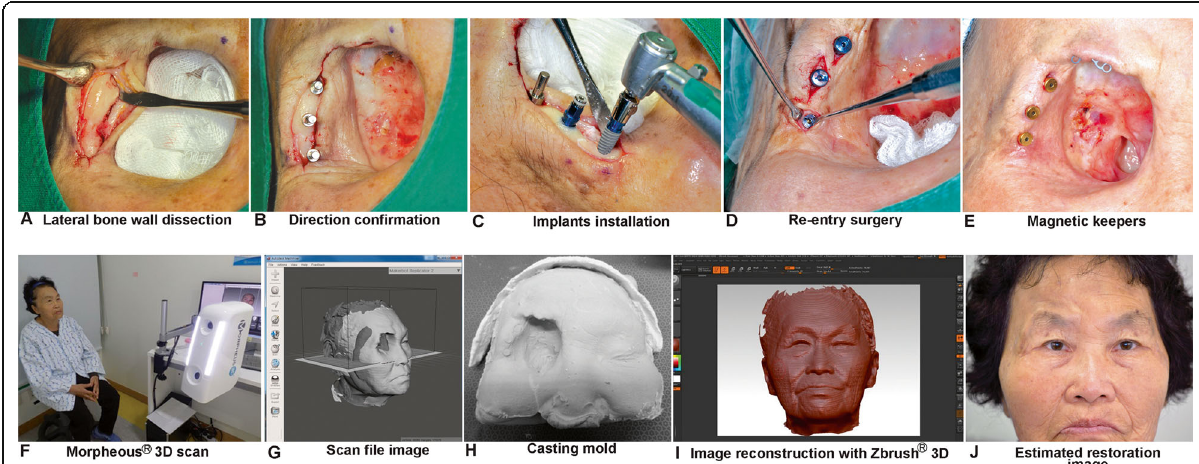
Fig. 2 Dental implant installation and 3D scanning with imaging reconstruction. A full-thickness cutaneous flap that exposed the lateral orbital bony wall ( a ); verification of the direction of three implants after drilling using a 2-mm-diameter drill bit ( b ); three Luna® implants (Shinhung Co., Seoul, Korea) 4.0 mm in diameter × 7.0 mm in length were inserted ( c ); the re-entry procedure showing the cover screws being changed into healing abutments 5 months later ( d ); replacement of the healing abutments with the magnetic keeper (MAGFIT IP-B®, Aichi Co., Japan) 4 weeks later (E); 3D facial scanning ( f ) and imaging reconstruction ( g ) with a Morpheus 3D Scanner® (Morpheus Co., Ltd., Seoul, Korea); 3D printing with the data obtained from facial scanning ( h ); 3D molding using ZBrush® image reconstruction software (Pixologic Inc., California, USA) to reconstruct the area with the defect ( i ); and application to the patient ’ s image ( j ) to design the expected